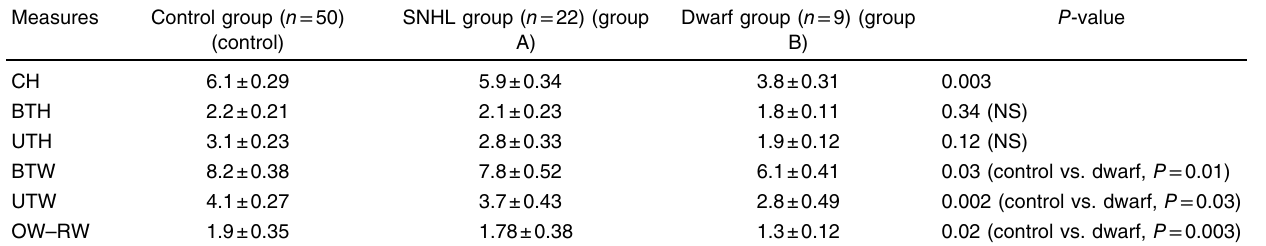
Table 2 Computed tomography measurements in all